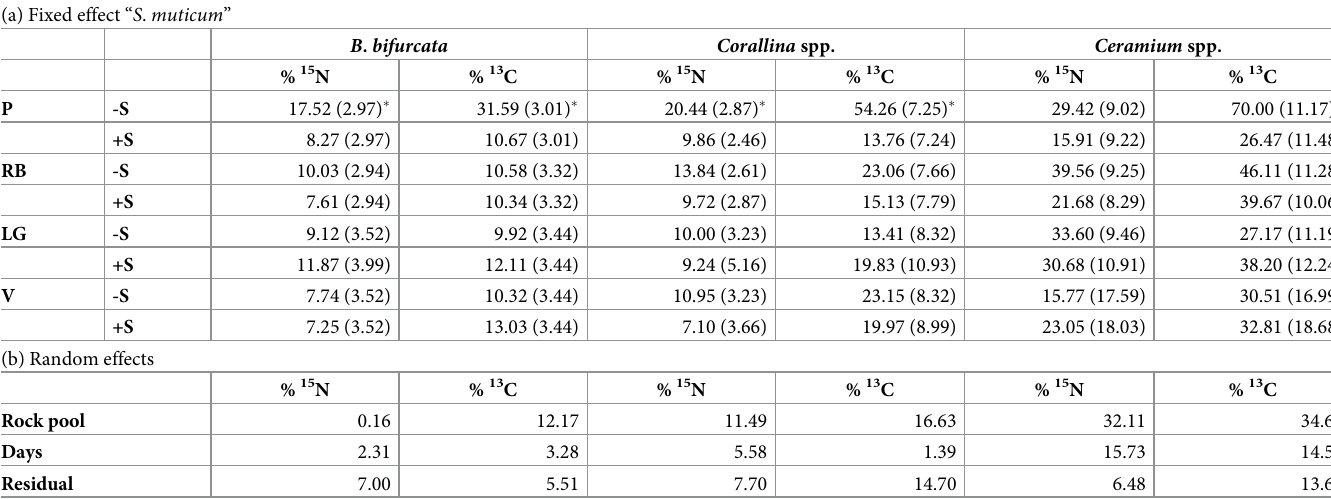
Table 1. Parameter estimates and standard errors of the GLM models for the excess E of 15 N and 13 C atoms in native macroalgae.